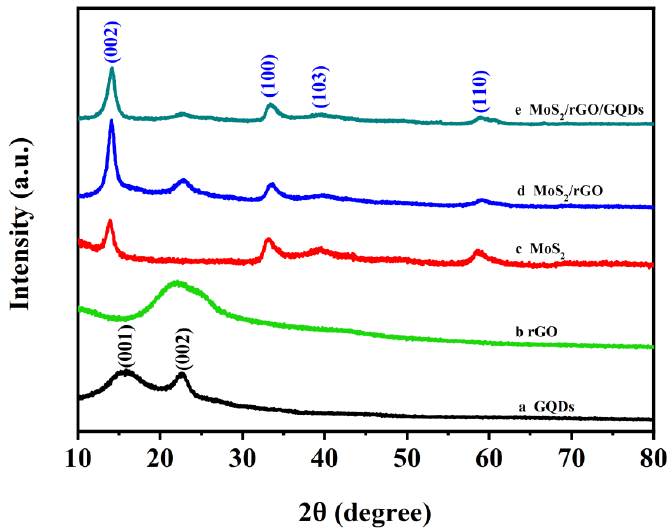
Figure 5. XRD patterns of ( a ) GQDs, ( b ) rGO, ( c ) MoS 2 , ( d ) MoS 2 /rGO, and ( e ) MoS 2 /rGO/GQDs.